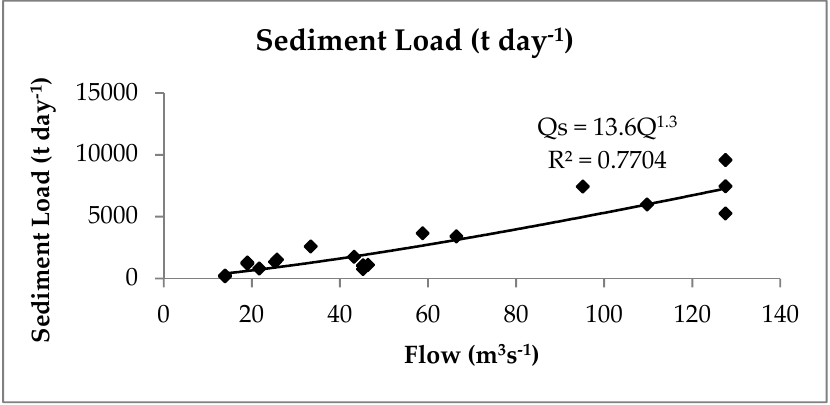
Figure 4. Sediment rating curve of the Logiya River at the Logiya gauge station.